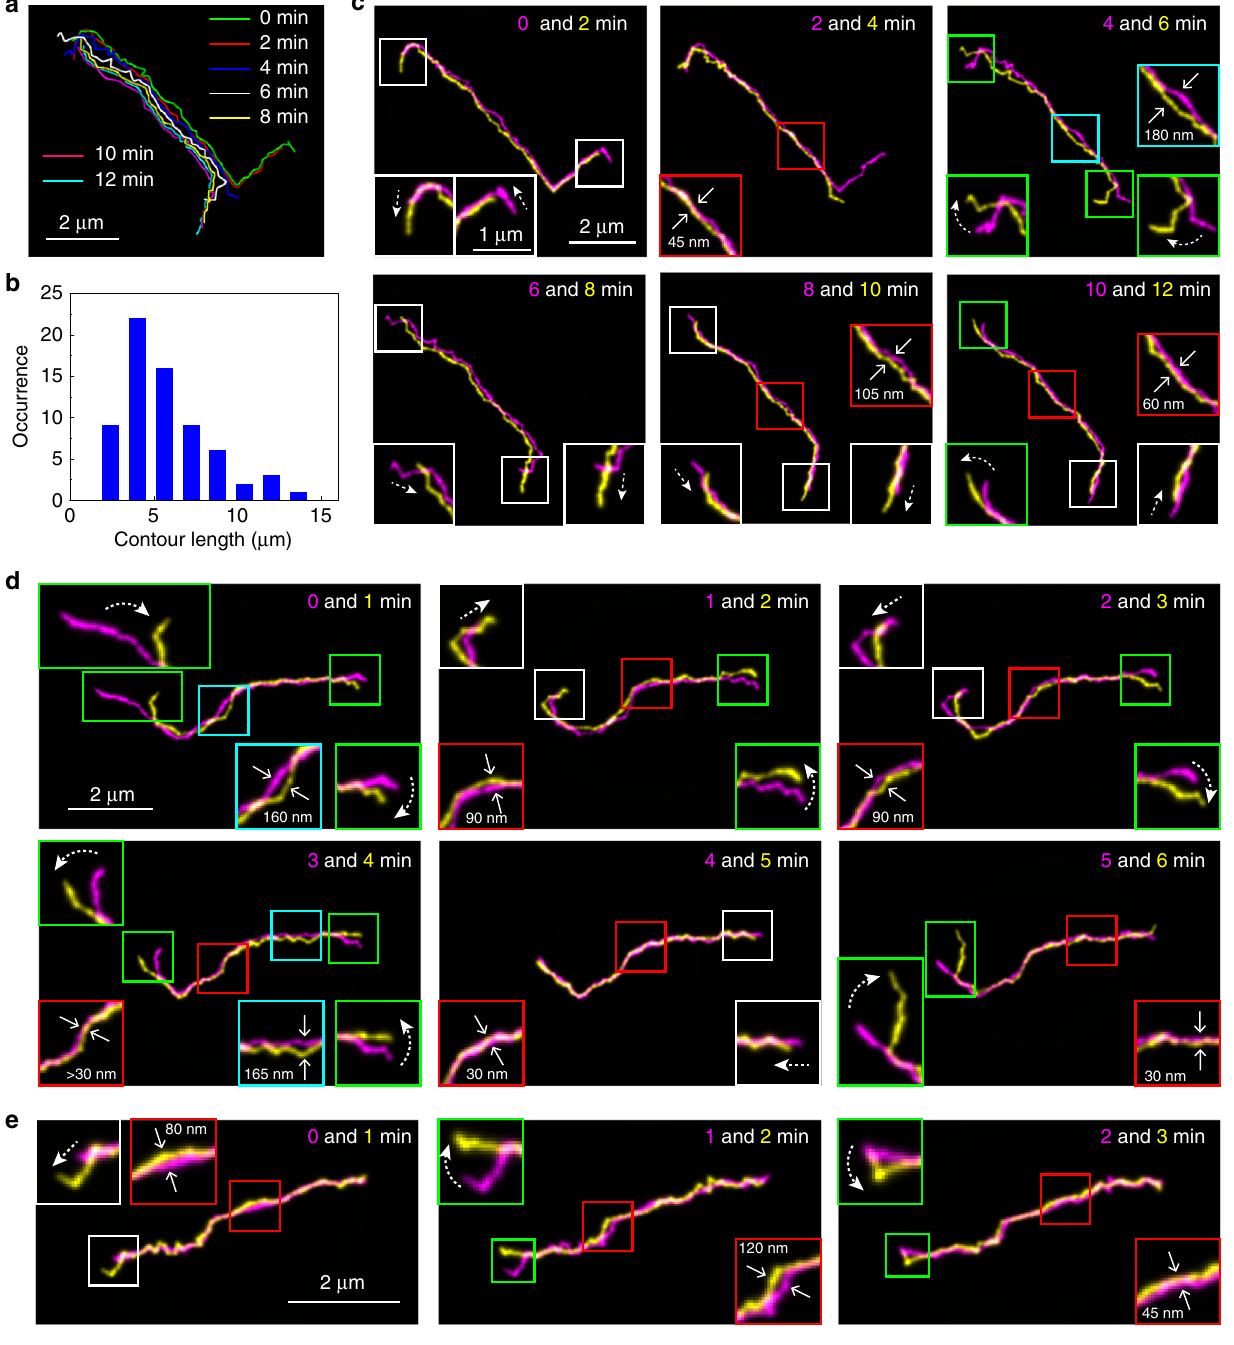
Fig. 4 Motion of the linear DNA molecules under entangled conditions. a Superimposed 3D contours of the Cy5-labelled lambda DNA in an aqueous solution containing 10 mg ml − 1 concentration of non-labelled lambda DNA. b Frequency histogram of the contour lengths of Cy5-labelled lambda DNA determined by the 3D contours of the molecules. The contours of the molecules were obtained in an aqueous solution containing 7 – 10 mg ml − 1 concentration of non-labelled lambda DNA. c 2D projected contours of the DNA molecule displayed in a . The local widths of the contours correspond to the standard deviations of the Gaussian at each local segment. Two contours obtained from adjacent time frames are shown in each panel in cyan (earlier time points) and yellow (later time points). Insets show enlarged views of the areas highlighted by the squares. d Another example of 2D projected contours of a Cy5-labelled lambda DNA molecule in an aqueous solution containing 10 mg ml − 1 concentration of non-labelled lambda DNA captured at different time points. The local widths of the contours correspond to the standard deviations of the Gaussian at each local segment. Two contours obtained from adjacent time frames are shown in each panel in cyan (earlier time points) and yellow (later time points). Insets show enlarged views of the areas highlighted by the squares. e 2D projected contours of a Cy5-labelled lambda DNA in an aqueous solution containing 7 mg ml − 1 concentration of non- labelled lambda DNA. The local widths of the contours correspond to the standard deviations of the Gaussian at each local segment. Two contours obtained from adjacent time frames are shown in each panel in cyan (earlier time points) and yellow (later time points). Insets show enlarged views of the areas highlighted by the